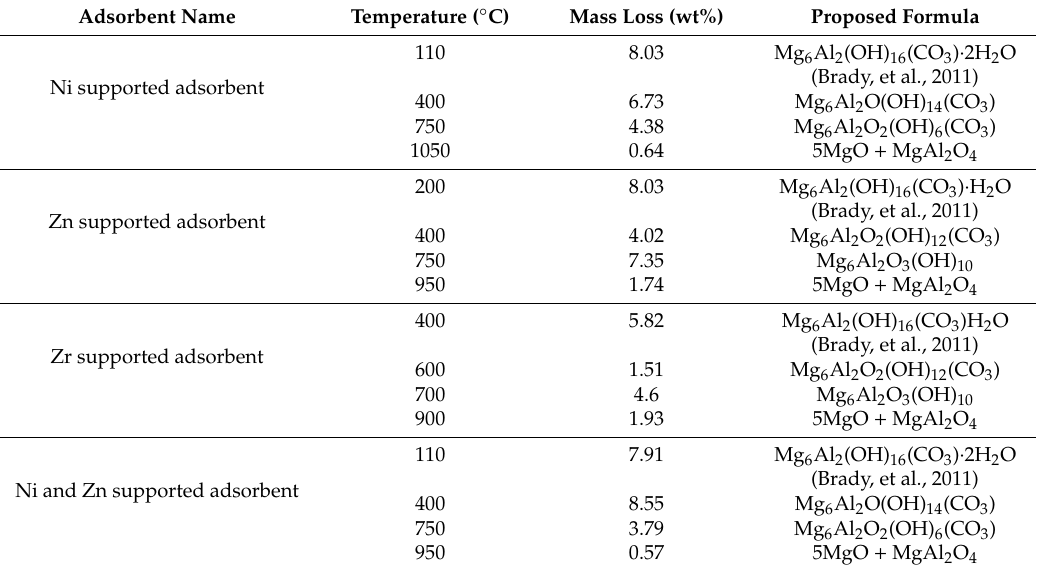
Table 3. Mass loss step for calcined five adsorbents.